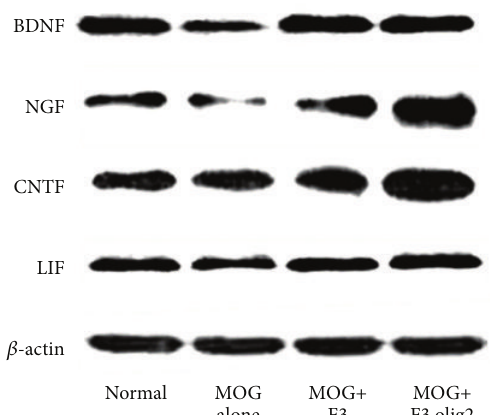
Figure 7: Effects of F3 or F3.olig2 cell transplantation on the myelin oligodendrocyte glycoprotein- (MOG-) induced change in the expression of growth and neurotrophic factors. BDNF: brain-derived neurotrophic factor, NGF: nerve growth factor, CNTF: ciliary neurotrophic factor, and LIF: leukemia inhibitory